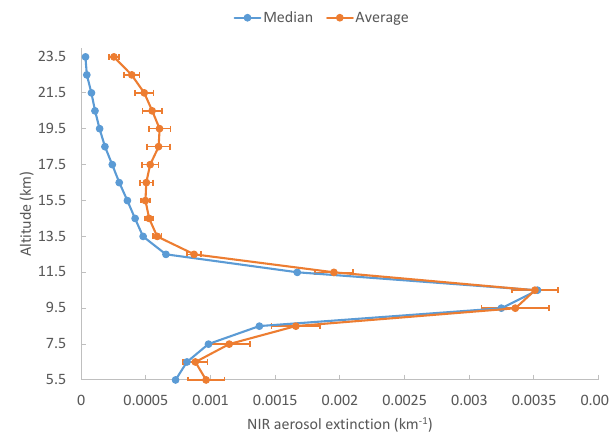
Figure 6. ACE-Imager median and average near-infrared (NIR, 1.02µm) aerosol extinction profiles for July 2011 at southern high latitudes ( N = 163). The error bar is ± 1 standard error of the monthly mean. The tropopause for this month and latitude band is typically at